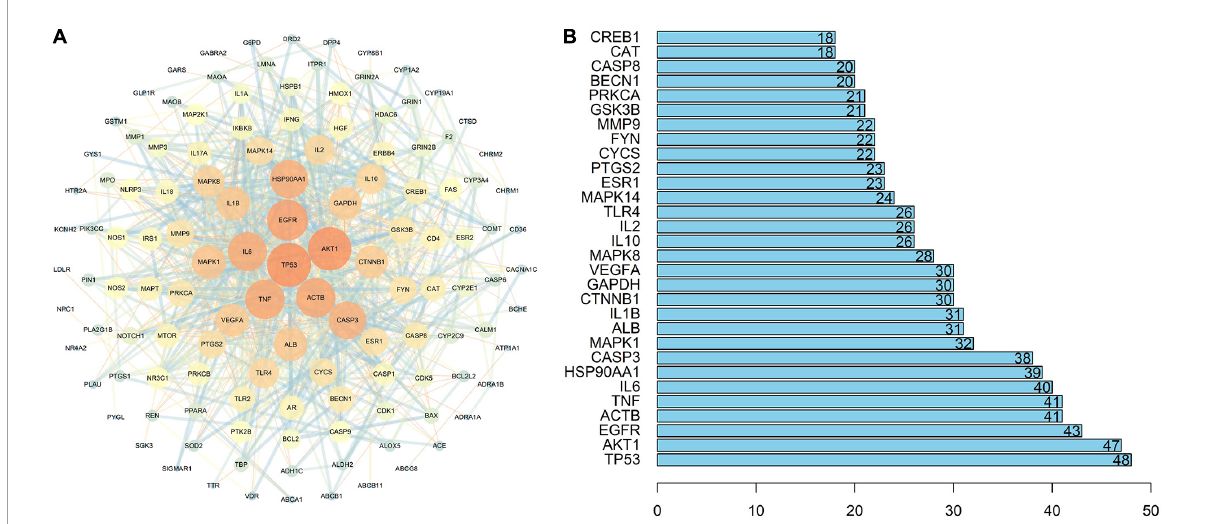
FIGURE4 Protein-Protein Interaction (PPI) network. (A) PPI network of the 135 common targets between QZZD and AD. Nodes represent target genes, and edges represent their interactions. The size and color of nodes are related to the value of degree. With increase of the degree, the size of nodes grows and the color gradually changes from blue to orange. The thickness and color of the edges are related to the combined score value. With increase of the combined score, the thickness of edges grows and the color gradually changes from orange to blue. (B) Core targets of PPI network. The numbers inside the bars represent the degree value of each target.